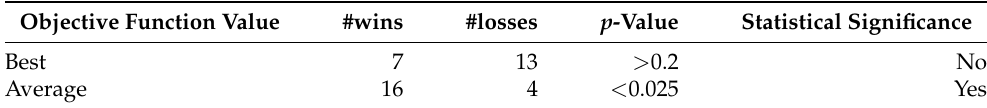
Table 7. Comparison of SA-R vs. VNS1 for larger sized